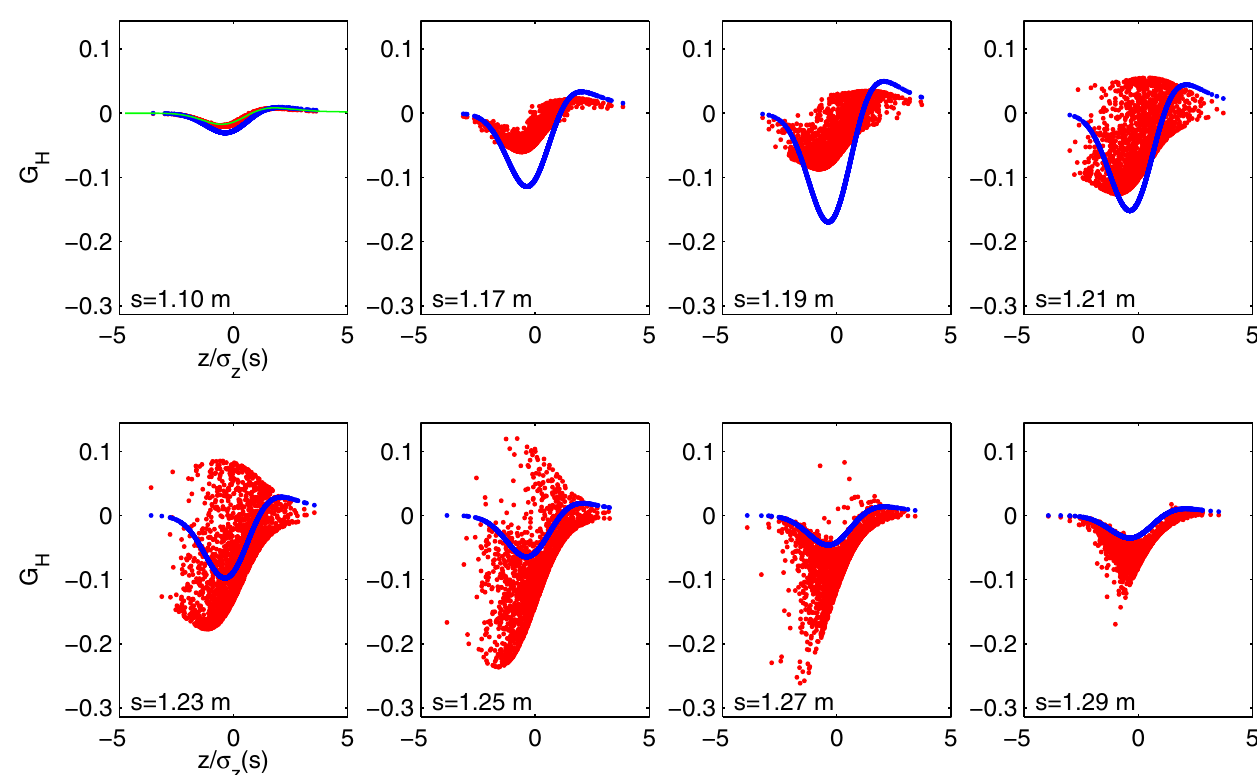
(cid:1) 1 mm - mrad nx 0